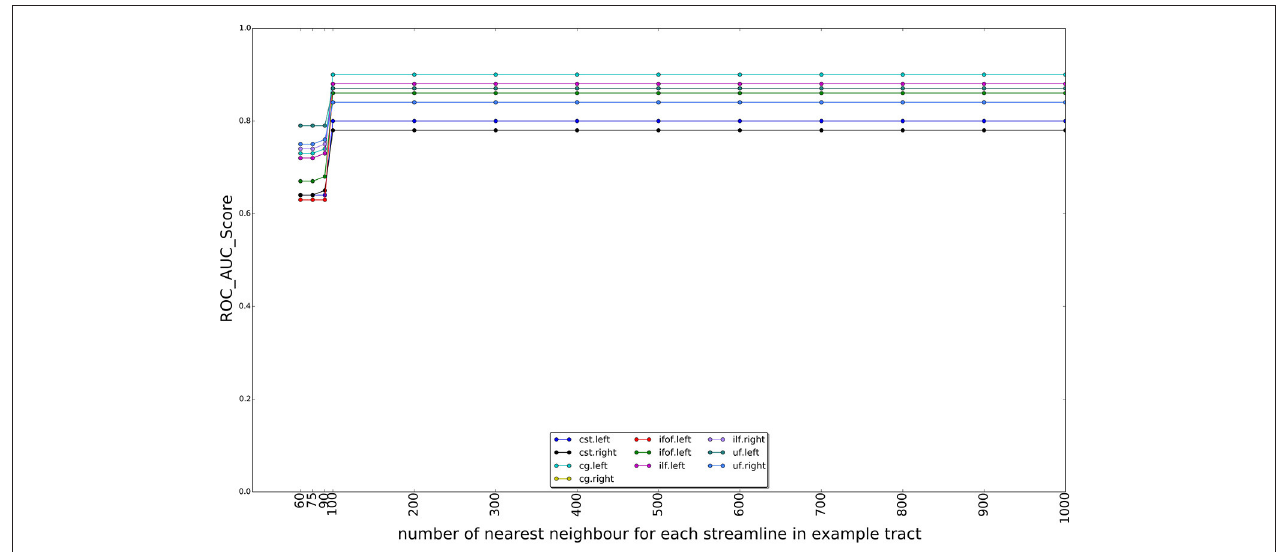
FIGURE 10 | Change on the AUC score with the number of the nearest neighbors for each streamline in example tract used to compute the superset of each example, in order to sparsify the cost matrix of the LAP. The plot reports the AUC scores for ten tracts over 15 subjects as the number of nearest neighbors increases from 60 to 1,000. After 100 neighbors the results are stable, i.e., the target tract is always included in the superset.